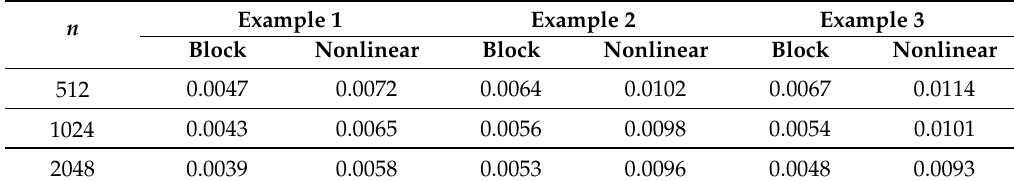
Table 1. The MSEs of the block and nonlinear wavelet estimators.